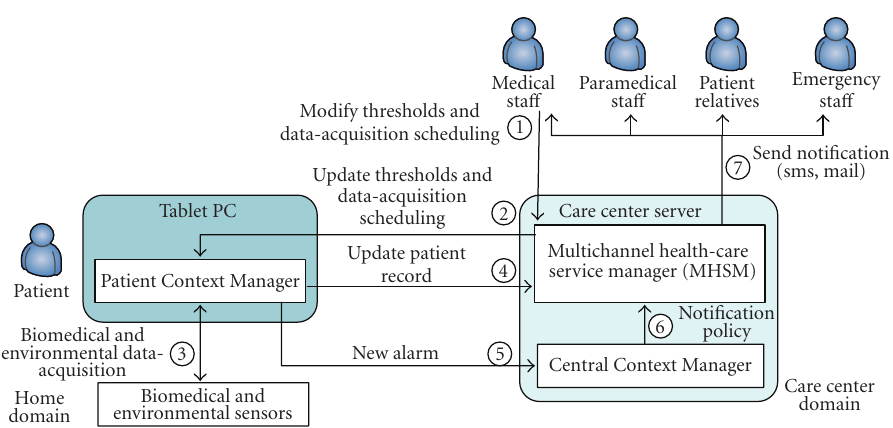
Figure 4: Alarm detection and management